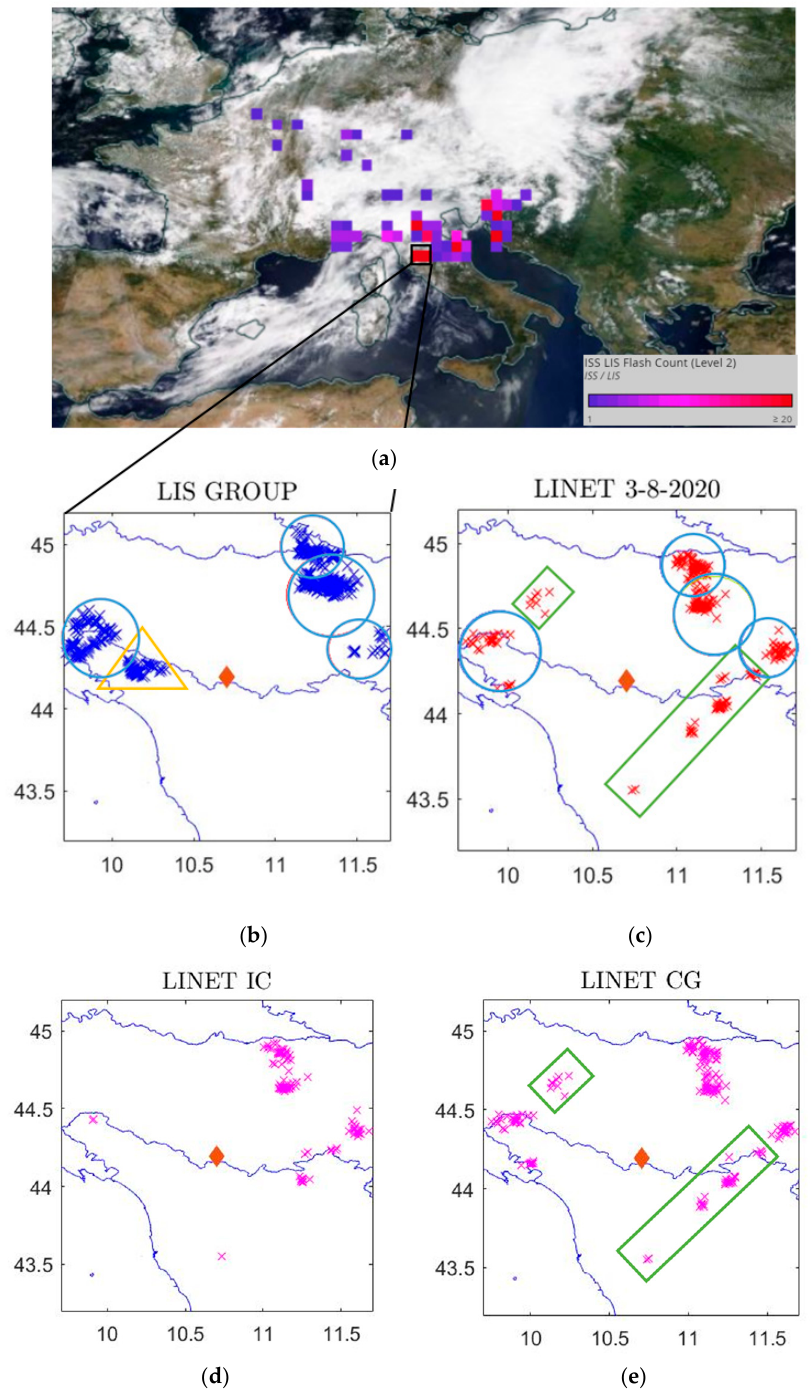
Figure 8. ISS-LIS and LINET lightning activity on 3 August 2020 extrapolated from the Moderate Resolution Imaging Spectroradiometer (MODIS). Lightning flashes observed are displayed, as well as the CG and IC flashes detected by LINET. ( a ) MODIS overpass over Europe; ( b ) ISS-LIS detection; ( c ) LINET relative detection; ( d , e ) LINET detection divided in IC ( d ) and CG ( e ).